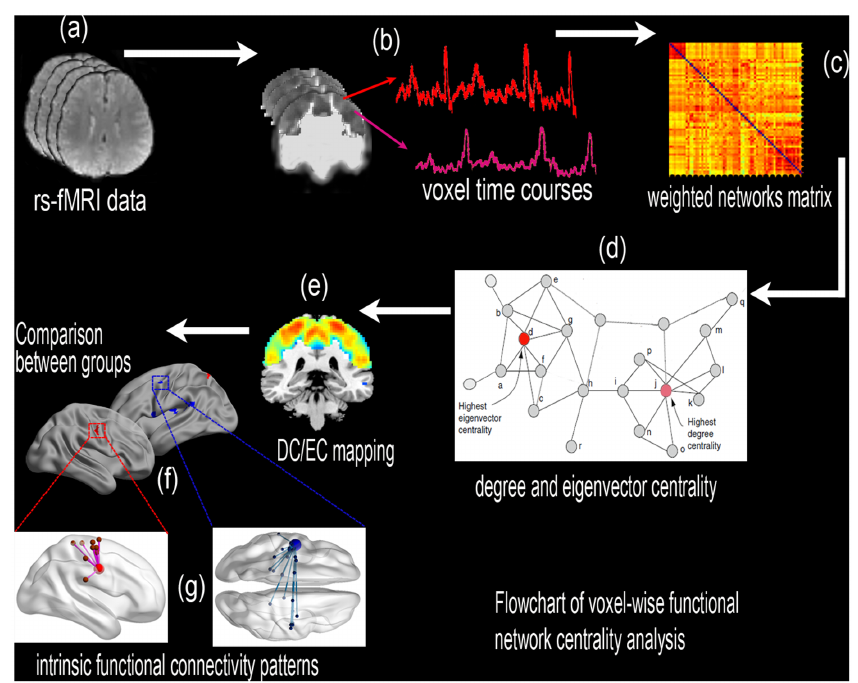
Fig 1. A flowchart of the voxel-wise functional network centrality analysis in the SMN. (a) Preprocessing of the resting-state fMRI data. (b) The time series of each voxel in the SMN template was extracted in MNI space, and (c) Pearson ’ s linear correlation was used to construct the voxel-wise weighted matrix. (d) Voxel-wise degree and eigenvector centrality (DC and EC) were calculated using the “ REST-DC ” and “ fast ECM ” toolkits, respectively. (e) The voxel-wise mapping of the SMN. (f) A comparison of network centrality between the groups. (g) Additional intrinsic functional connectivity patterns.